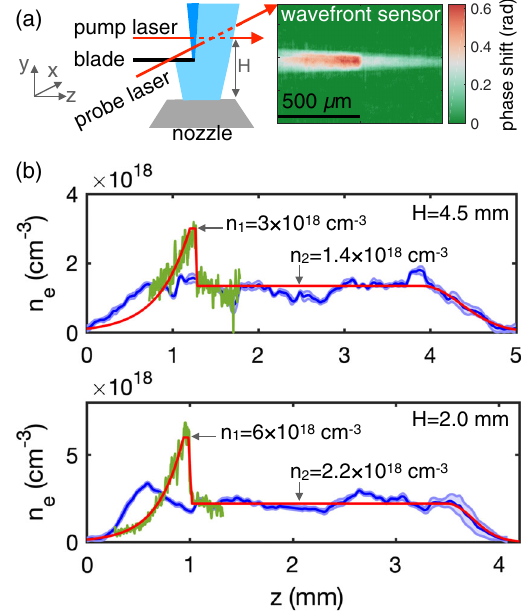
FIG. 1. Schematic of the experimental setup (a) and the measured density profiles (b). The plasma density was measured using a wave front sensor, and a representative phase map is shown in (a). The blue lines in (b) show the measured density profiles without a blade (averaged over 20 shots, synthesized using 4 – 5 frames in the z direction due to the ∼ 1 -mm-wide view of the camera) at different heights above the nozzle exit. The shaded region represents the standard deviation. The green lines are the measured density profiles with a blade inserted (single shot). The red lines are simplified density profiles used in